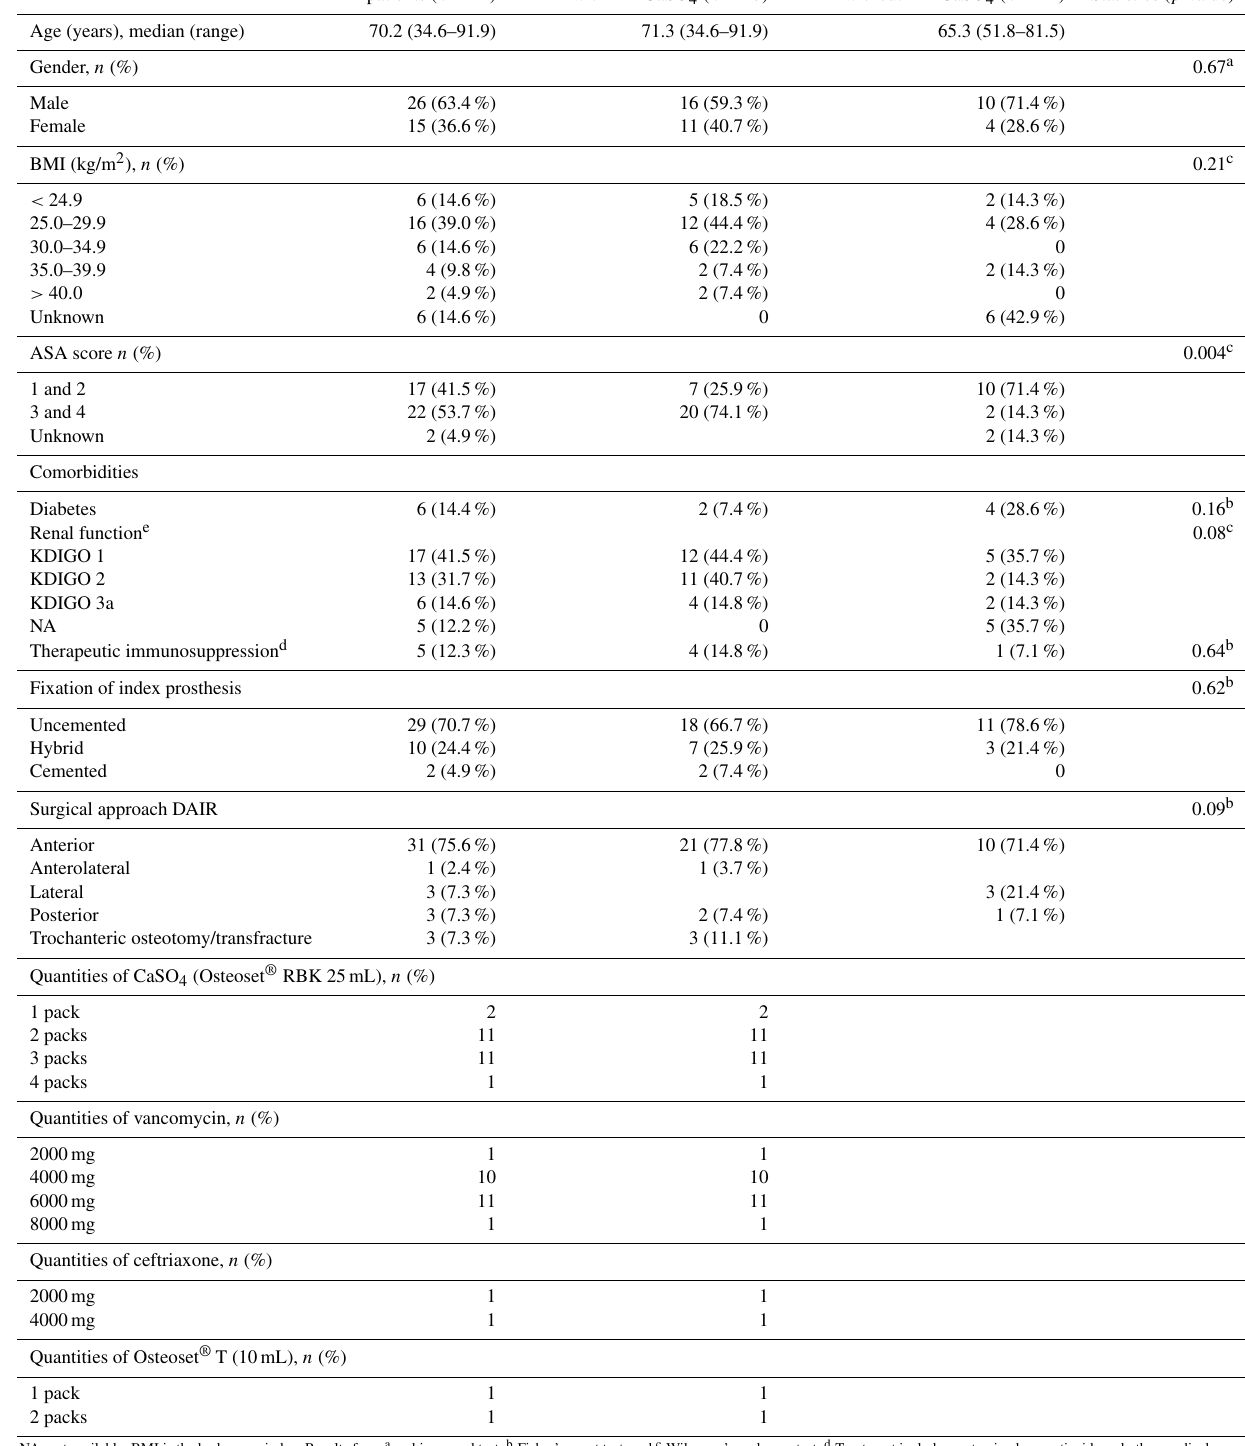
Table 1. Demographic data and surgical characteristics of the study population. There are no statistically significant differences between both groups. All categorial data were compared with chi-squared tests, while a non-parametric test was used for age. The resorbable bead kit (RBK) was mixed with vancomycin or ceftriaxone, according to the causative bacteria and identified antibiotic resistances. Osteoset ® T (Wright Medical Technology, Inc.) is a ready-to-use product, containing 400mg of tobramycin sulfate per 10mL of beads. All patients ( n = 41) DAIR with AB-CaSO 4 ( n = 27)